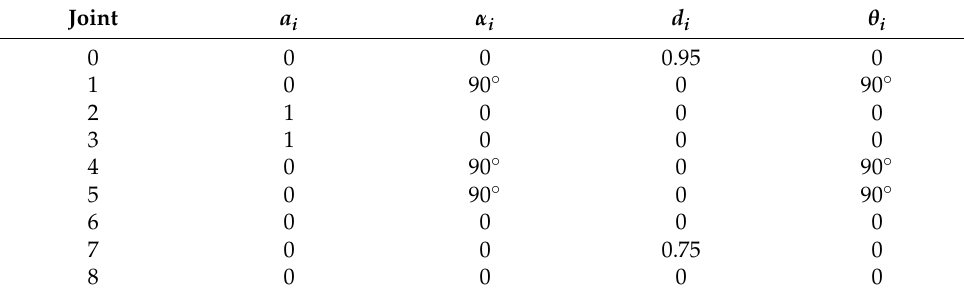
Table 5. DH parameters of the space detumbling robot.